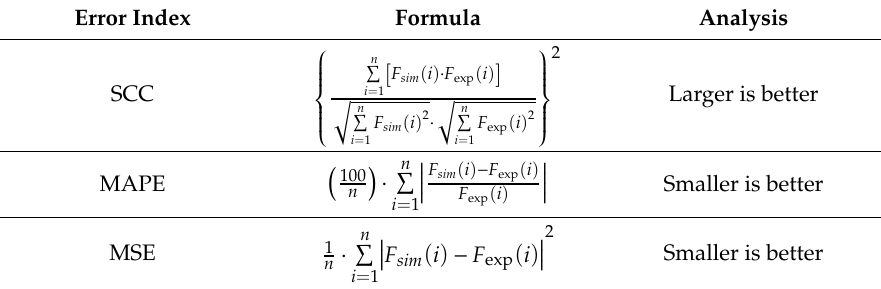
Table 2. Expression of error evaluation